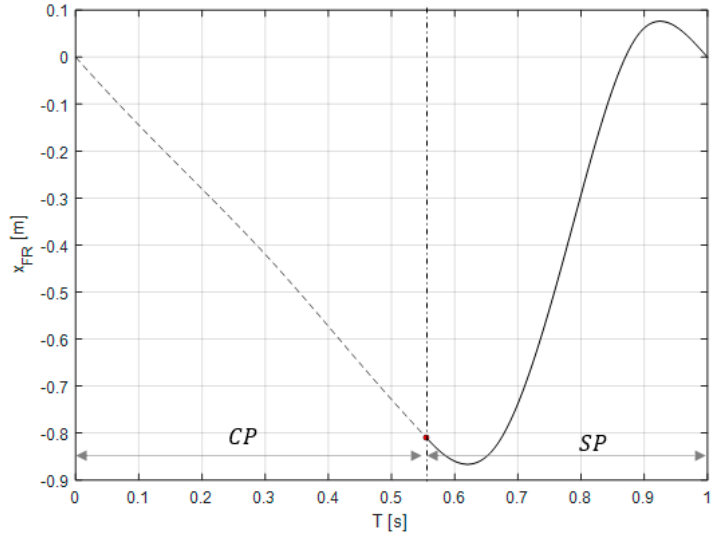
Figure 13. FR foot trajectory during contact and swing phase starting from 𝑡 𝐹𝑅 . To better assess the variability of the results, a statistical analysis on 10 runs of the optimization algorithm was performed. In all cases, the best gait found was the walking- trot and the ratio between the value of the objective function and its average differs by a maximum of 2.5%, as observed in Figure 14.